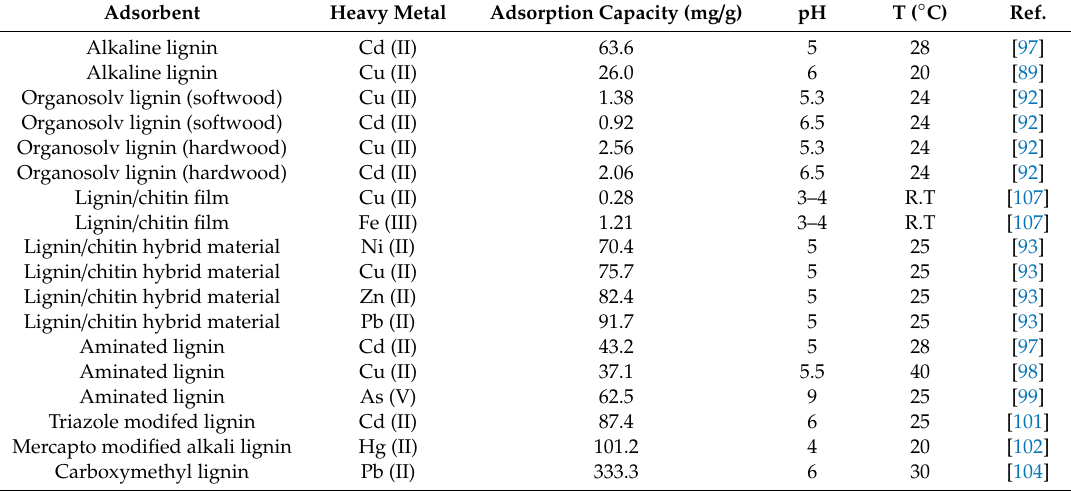
Table 2. Adsorption capacities of as-obtained and modified lignin for heavy metals in water.